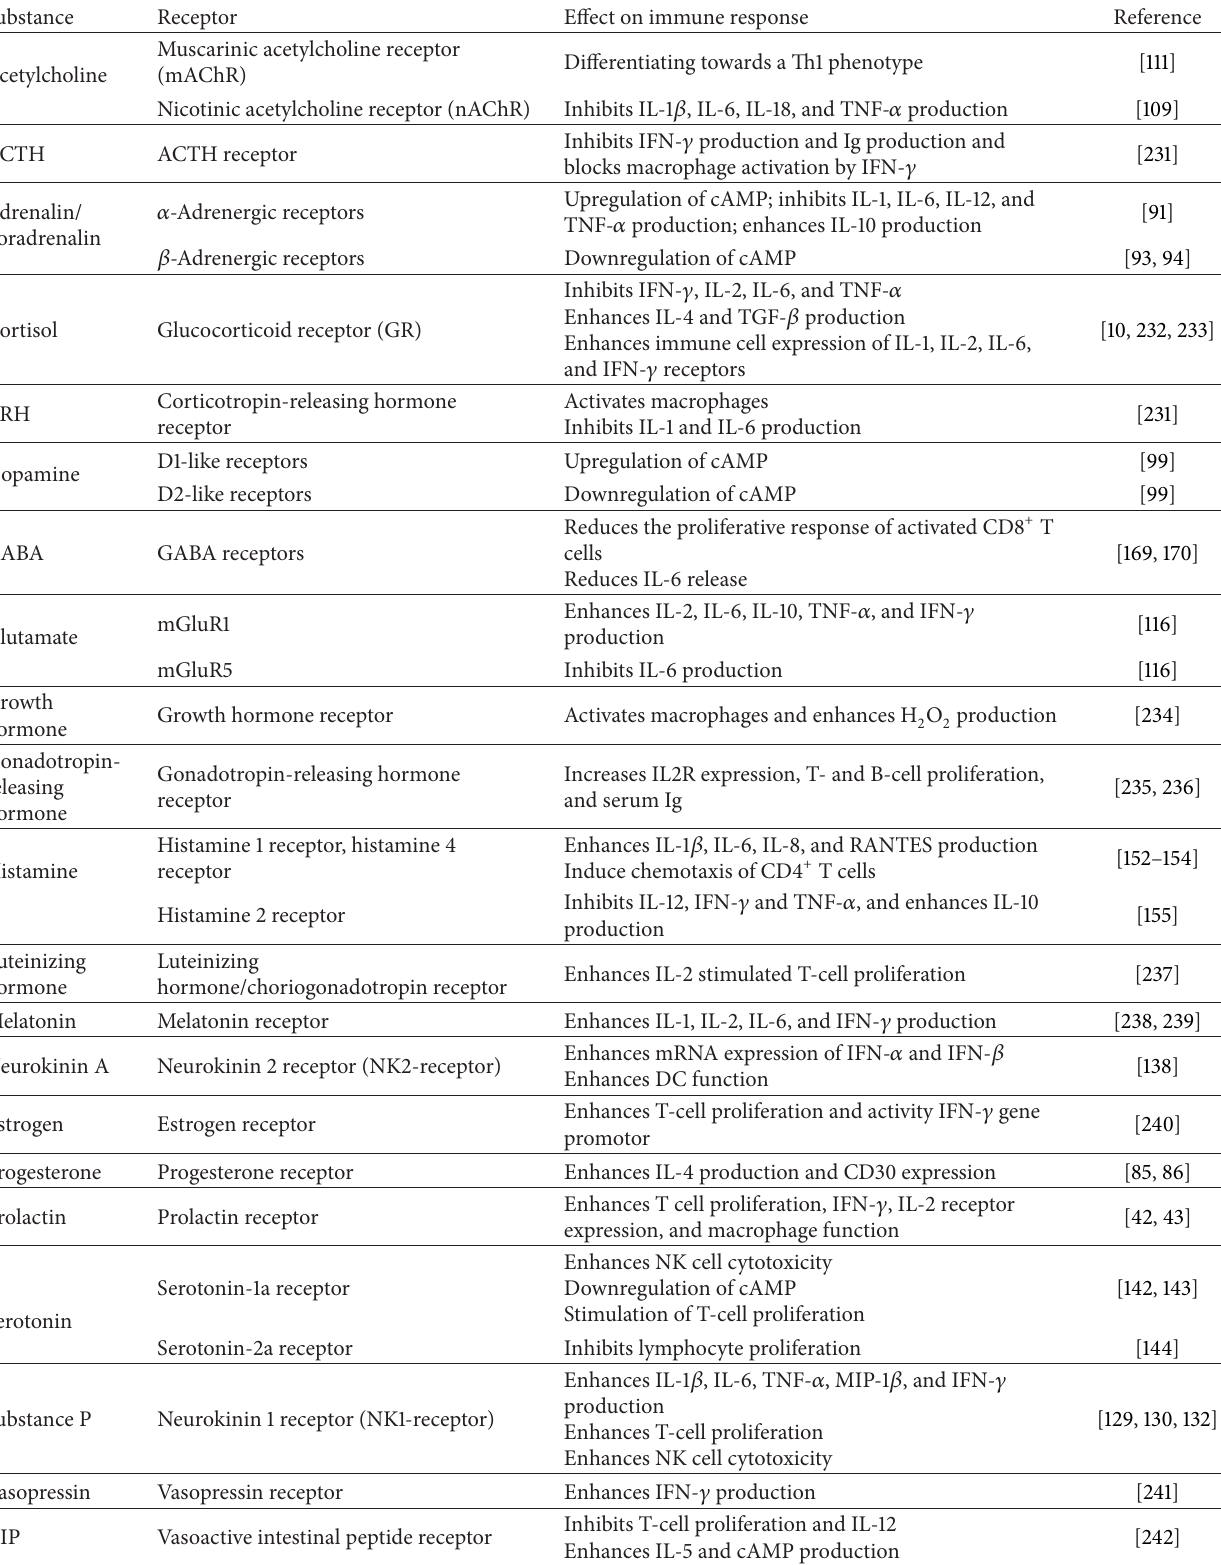
Table 1: Neuroendocrine factors and their immunomodulatory